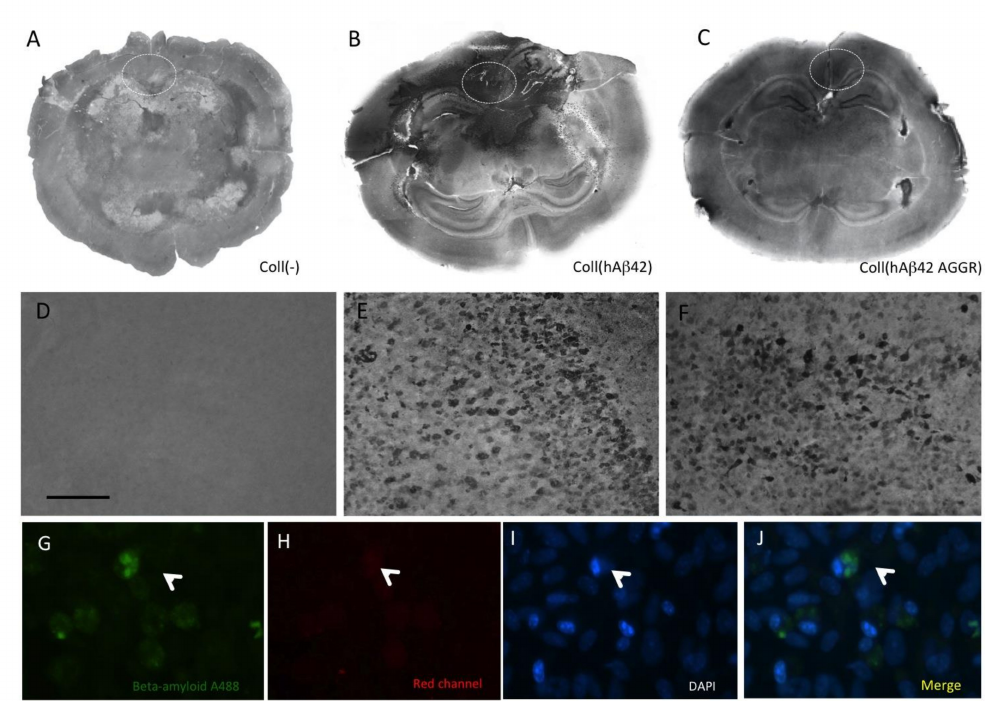
Figure 5. Overview of beta-amyloid (A β ) spreading in brain slices. Two half-brain slices were connected and after one week the collagen hydrogel (Coll) was loaded without ( A , D ) or with ( B , E ) human A β 42 , or with aggregated (AGGR) A β 42 ( C , F ), placed onto the upper “donor slice” and incubated for eight weeks, then fixed and stained with the A β antibody. Note the severe A β -like immunoreactivity all over the donor slice and also partly in the target slice after application of human A β 42 . Severe intracellular A β -like immunoreactivity was visible ( E , F ). Co-staining of A488-labeled A β (green, G ) with nuclear DAPI (blue, I) showed cellular staining in the cytoplasm (J), while the staining was negative in the red channel ( G ). Scale bar in D = 220 µ m ( A – C ), 150 µ m ( D – F ) and 50 µ m ( G – J